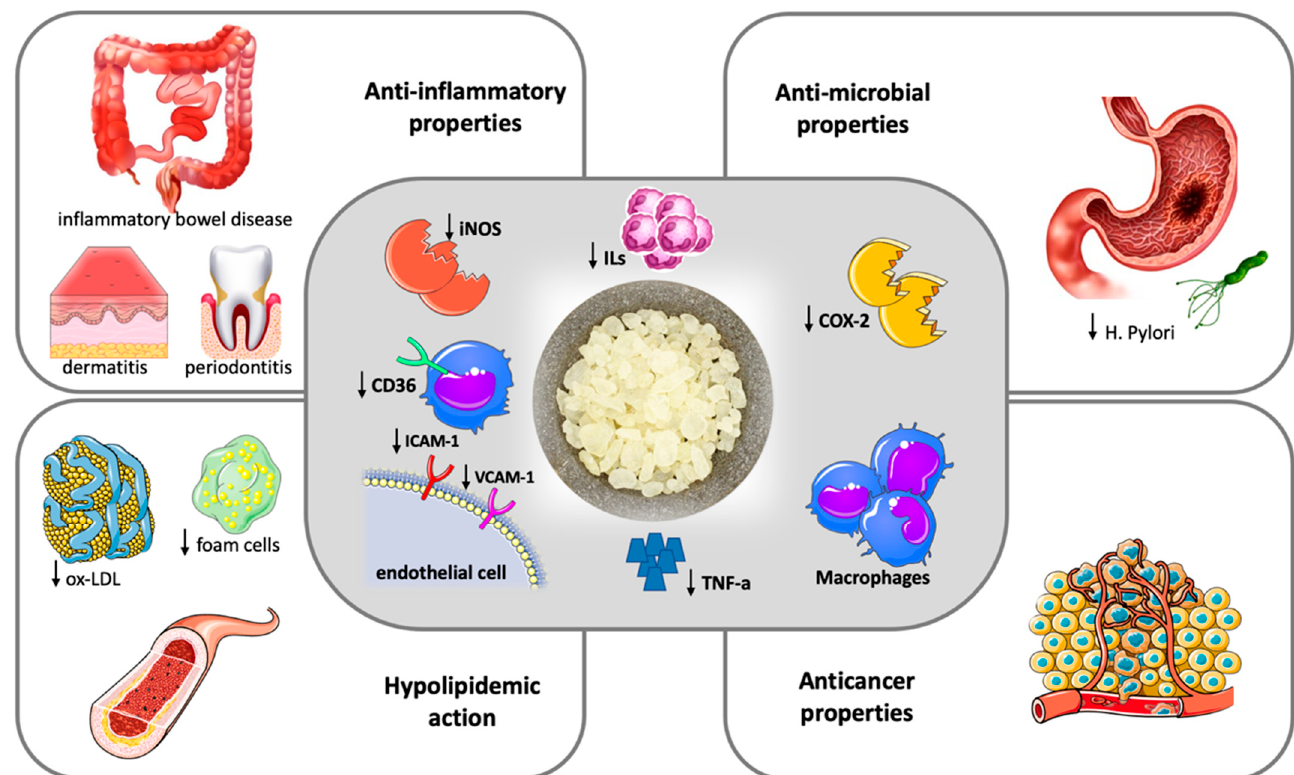
Figure 1. Therapeutic potentials of Chios Mastic.